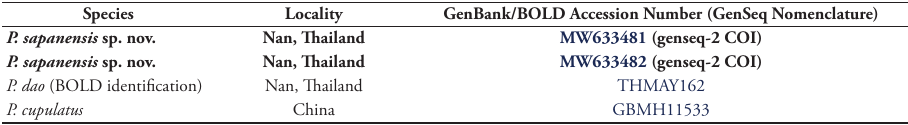
Table 1. Sequenced specimens of the genus Paegniodes (new sequence indicated in bold). Species